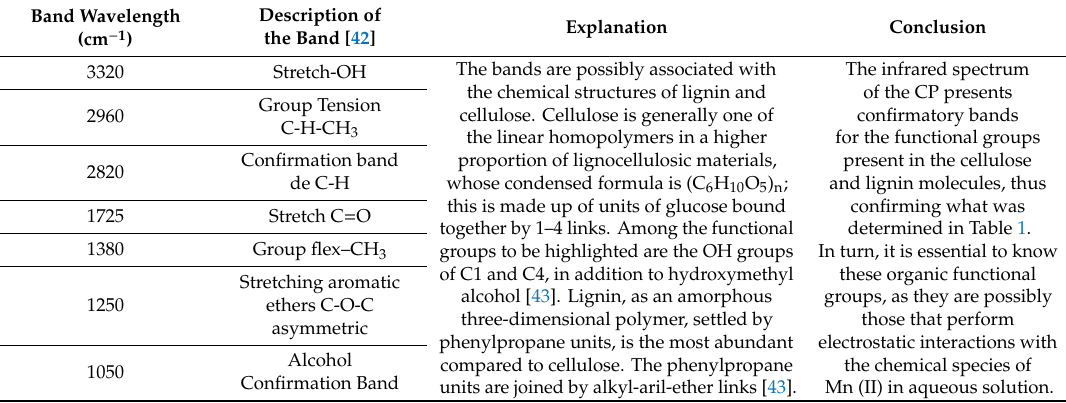
Figure 1. The infrared spectrum of the CP before the Mn (II) bioadsorption process. The reading of the IR spectrum, by the total attenuated reflection (TAR) technique, was done in order to analyze the bands of the organic functional groups characteristic of agricultural waste, and which may be associated with the removal of the pollutant, in this case, the Mn (II). Therefore, Table 2 shows descriptions of the absorption bands. Table 2. CP IR spectrum absorption bands before the Mn (II) bioadsorption process.